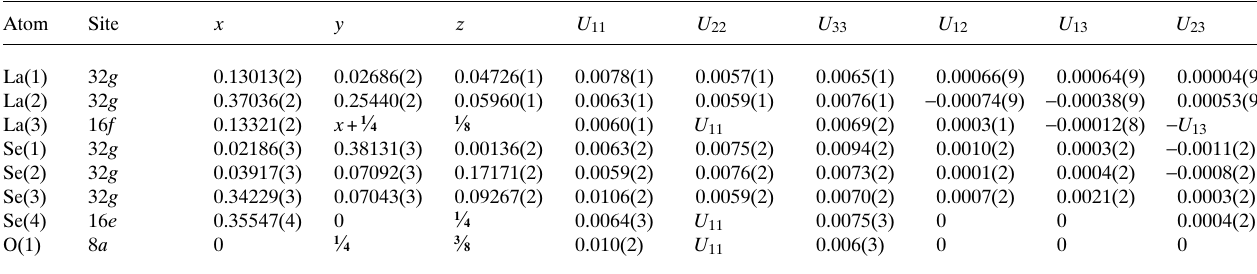
Table 2. Atomic coordinates and displacement parameters (in Å 2 )